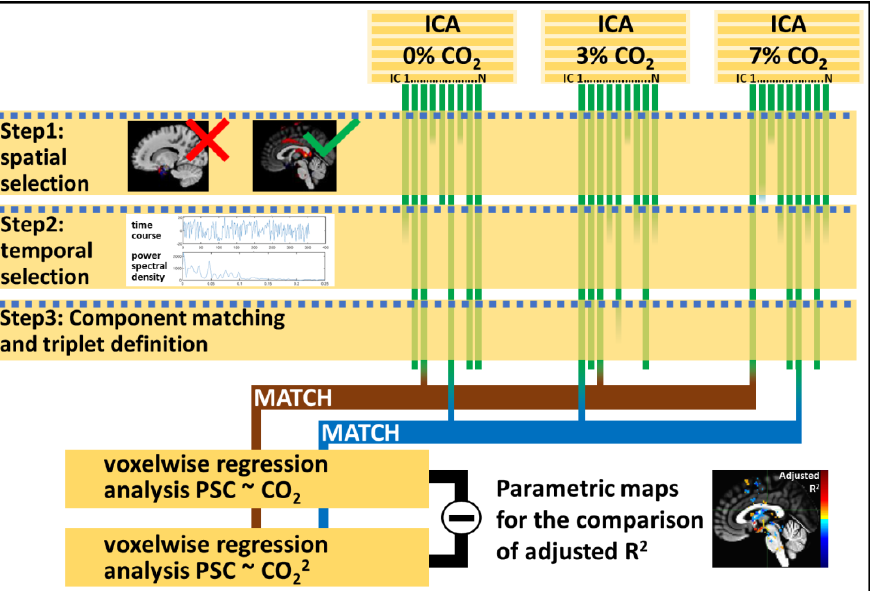
Figure 2. Proposed analysis pipeline: three separate masked Independent Component Analyses are performed on the three conditions. Extracted components (green lines) undergo three steps of se-